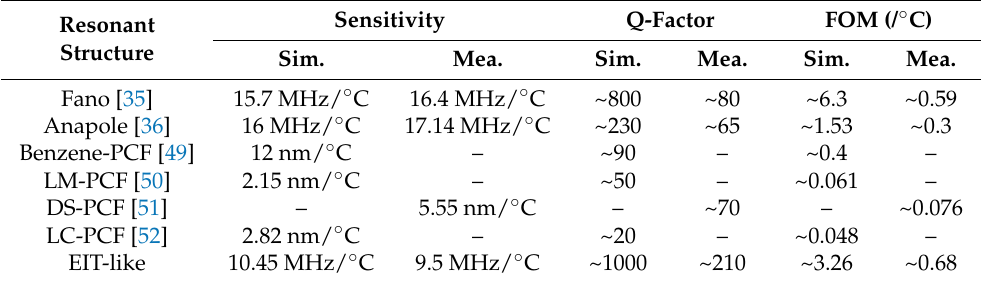
Table 1. Performance comparisons for the proposed temperature sensor structures. Resonant